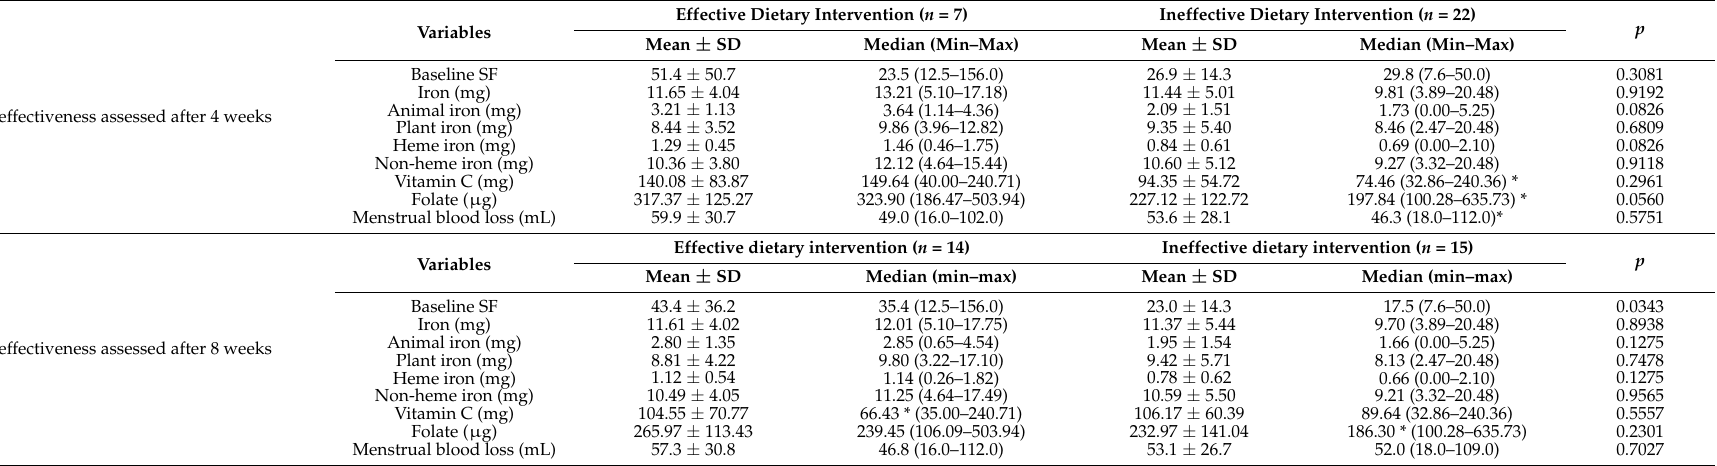
Table 8. The comparison of the baseline characteristics of the subsamples (serum ferritin level, dietary intake, and menstrual blood loss) in subsamples stratified by the effectiveness of dietary intervention assessed for serum ferritin level after 4 and 8